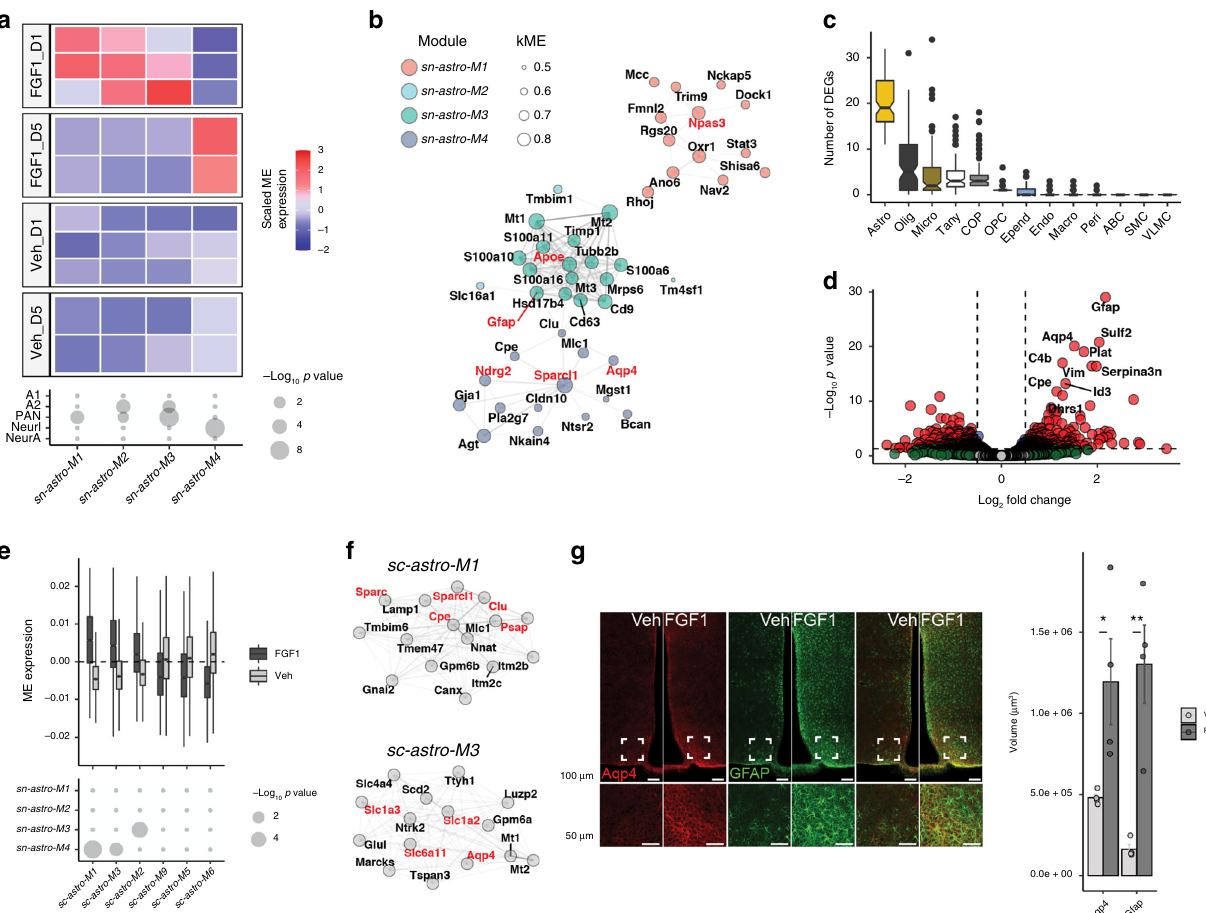
Fig. 3 Evolution of the astrocyte response to icv FGF1. a Identi fi cation of sn-astro-M1 – sn-astro-M3 upregulated at Day 1 and sn-astro-M4 upregulated at Day 5 in FGF1-treated mice (linear mixed-effects model, FDR < 0.05) using WGCNA on astrocytes from the snRNA-seq datasets. Enrichment of DEGs in astrocytes in response to lipopolysaccharide (neurotoxic, A1), middle cerebral artery occlusion (neuroprotective, A2), or overlapping genes (PAN) 25 or enrichment of genes induced by neuron interaction (NeurI) or neuron activity (NeurA) 31 . Point size is scaled by − log 10 ( p value) (Bonferroni adjusted). b Correlation of top 15 genes of sn-astro-M1 – sn-astro-M4 . Node size; correlation of the given gene with the module eigengene (kME). c Number of DEGs for non-neuronal subclusters identi fi ed in the Day 5 scRNA-seq dataset with repeated downsampling (10 cells/group/cell type/iteration, 100 iterations; n = 6 mice/group), median (IQR). Summary statistics provided as a Source data fi le. Macro macrophages, Peri pericytes, ABC arachnoid barrier cells, SMC smooth muscle cells, VLMC vascular leptomeningeal cells. d Volcano plot of pseudobulk DEGs in astrocytes Day 5, scRNA-seq dataset between FGF1 and vehicle. Blue, genes with FDR < 0.05; red, genes with FDR < 0.05 and |log 2 fold change| > 0.25; green, genes with |log 2 fold change| > 0.25; gray, genes below both thresholds. e Astrocytes WGCNA (Day 5; scRNA-seq) identi fi ed three signi fi cant upregulated ( sc-astro-M1 – sc-astro-M3 ; linear mixed-effects model; FDR < 0.05) and three downregulated ( sc-astro-M5 , sc-astro-M6 , sc-astro-M9 ) modules in FGF1-treated mice, median (IQR). Lower panel: hypergeometric enrichment analysis of single-nucleus RNA-sequencing (snRNA-seq) and scRNA-seq astrocyte modules. Point size is scaled by − log 10 ( p value) (Bonferroni adjusted; n = 6 mice/group). f Correlation of top 15 genes in modules sc-astro-M1 and sc-astro-M3 . g Representative images of immunoreactivity of aquaporin 4 (Aqp4; red) and glial fi brillary acid protein (GFAP; green) from coronal sections of hypothalamus from diabetic Lep ob/ob mice 1 week after either vehicle or FGF1 icv injection. Lower panels: higher magni fi cation of white inset. Scale bar 100 μ m (top), 50 μ m (lower). Pixel dimensions: 0.27 × 0.27 × 2.00 microns. Quanti fi cation: dots represent volume of Aqp4- or GFAP-positive voxels for individual animals (mean from 2 sections per animal, n = 4/group), mean ± SEM. Unpaired t test, two tailed, * p = 0.037, ** p = 0.003 (not adjusted). Source data are provided as a Source data fi le. Genes mentioned in the text are labeled in